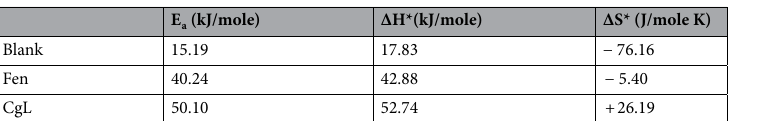
E a (kJ/mole) ∆H*(kJ/mole) ∆S* (J/mole K) Blank 15.19 17.83 − 76.16 Fen 40.24 42.88 − 5.40 CgL 50.10 52.74 + Table 7. The activation parameters, obtained from polarization measurements, of steel in 20% phosphoric acid solution in the absence and presence of Fen or CgL.